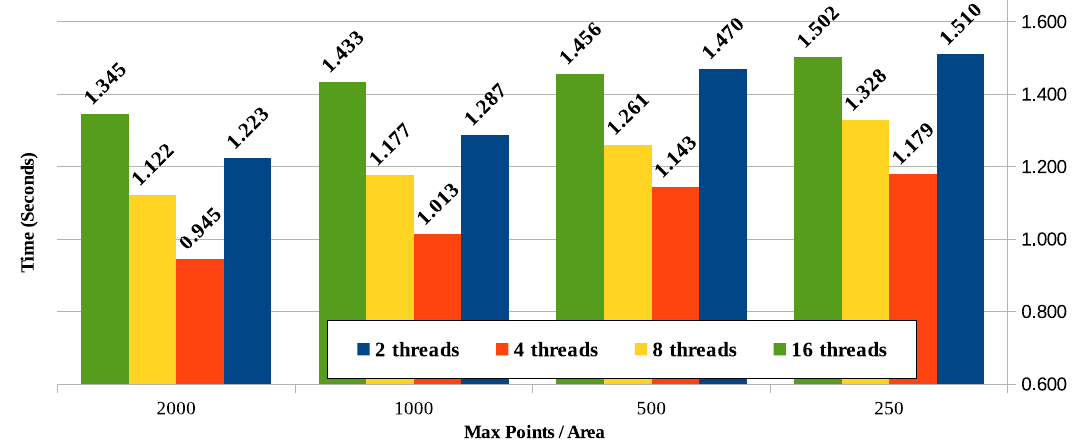
Figure 18. Pair detection algorithm response time in C